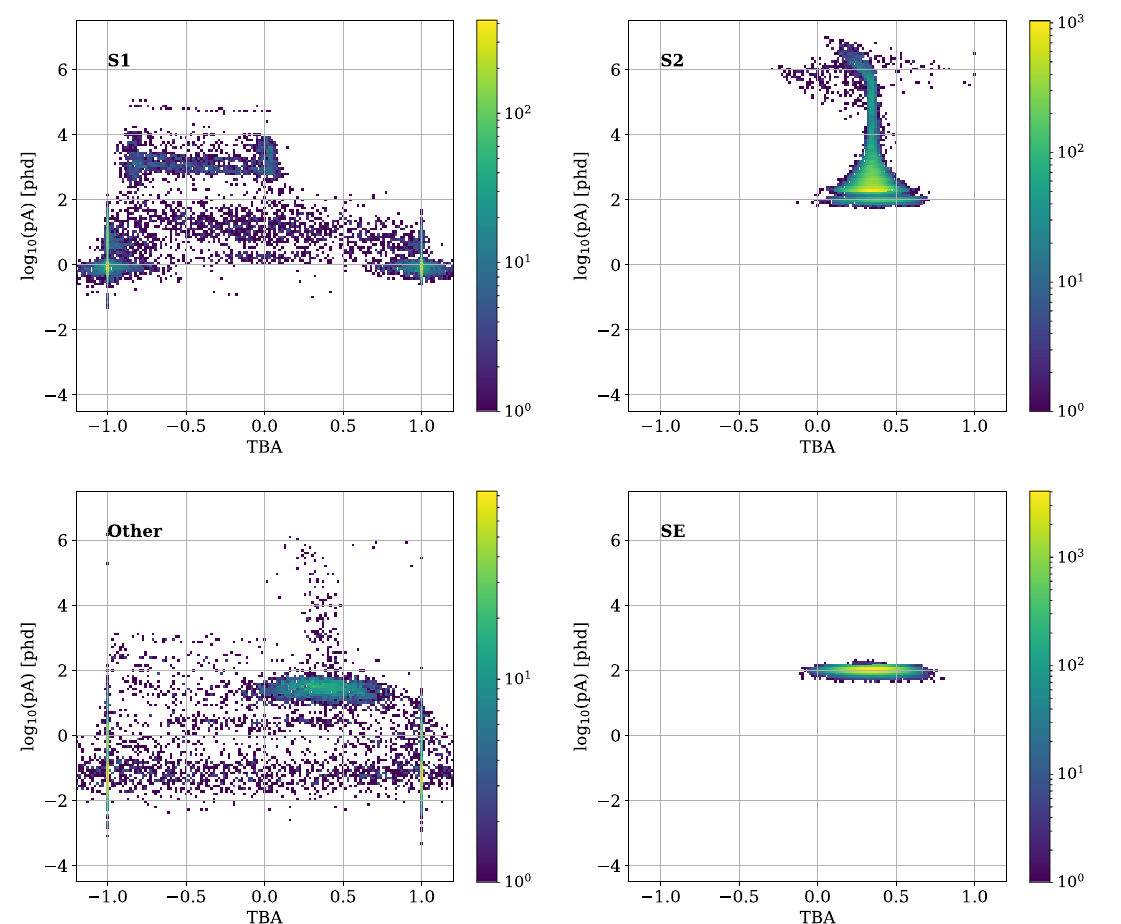
Fig. 4 Distribution of the pulse populations in the marginal distribu- tion TBA vs pA after being processed by the RFClassifier. The top-left plotdisplaysthedistributionofpulsesclassifiedasS1.Thetoprightplot